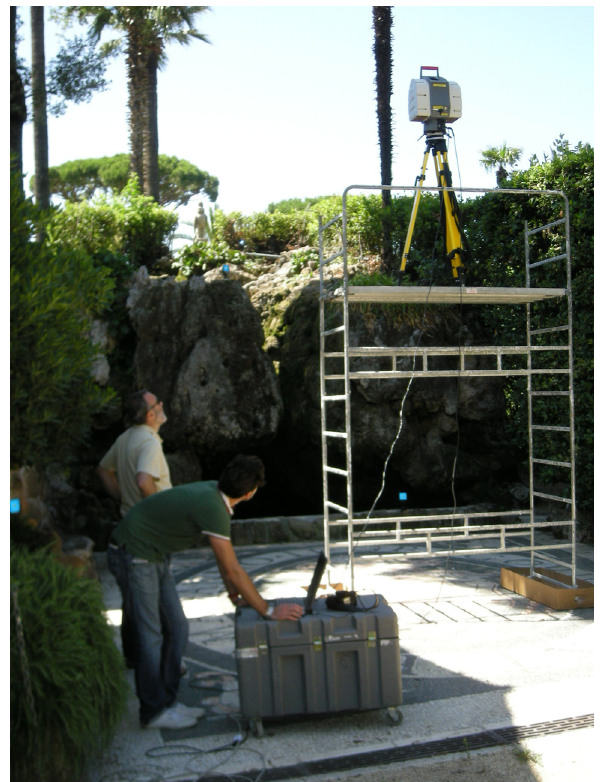
Figure 4. Acquisition data phases with laser scanner.